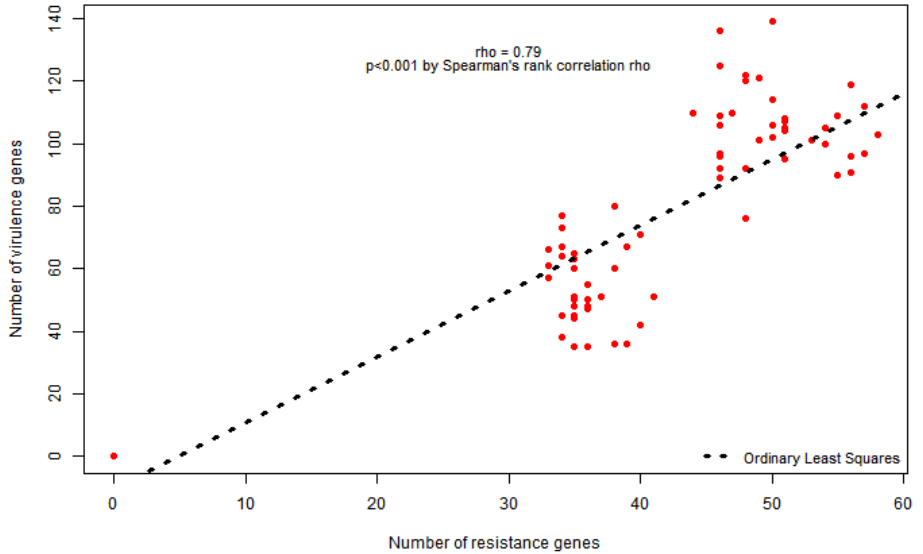
Figure 1. Spearman’s rank correlation between number of resistance and virulence genes. Table 4. Median number of classes of virulence genes carried per bacterial strain.